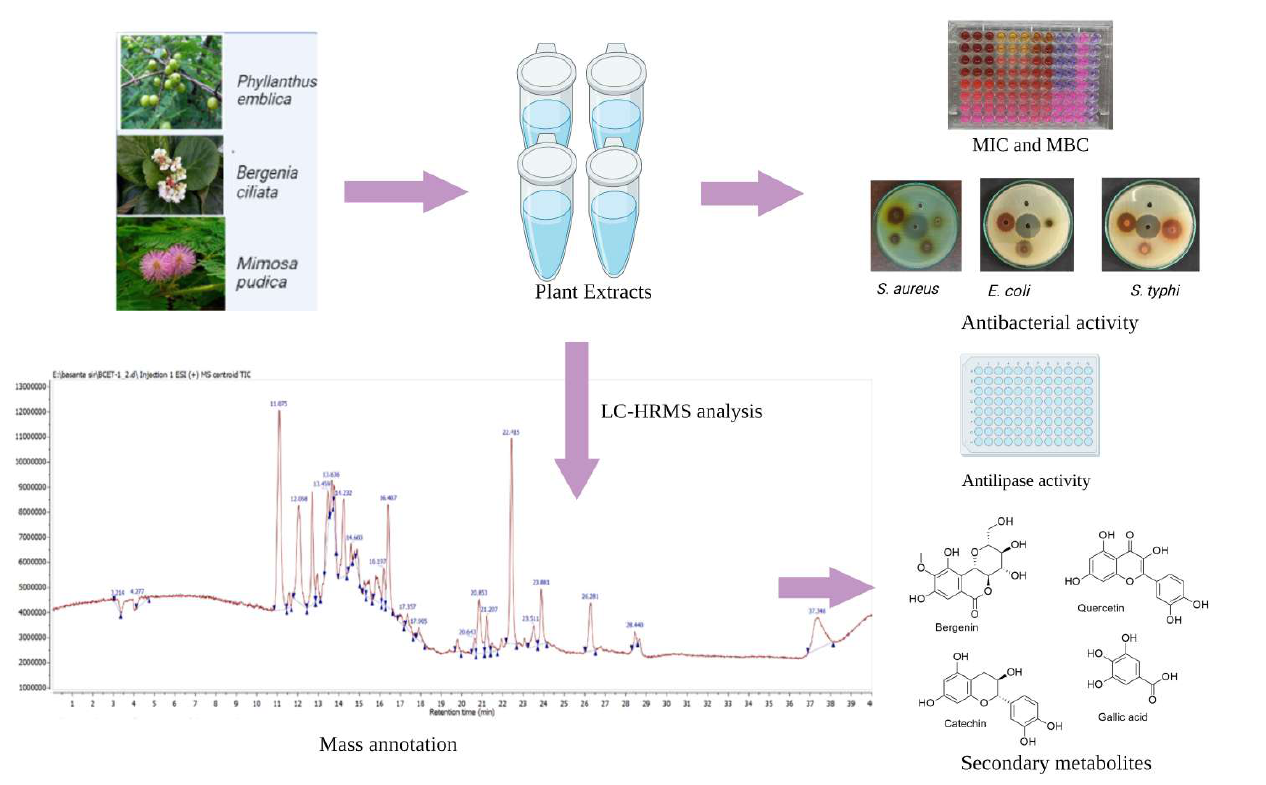
Figure 1. Overview of the